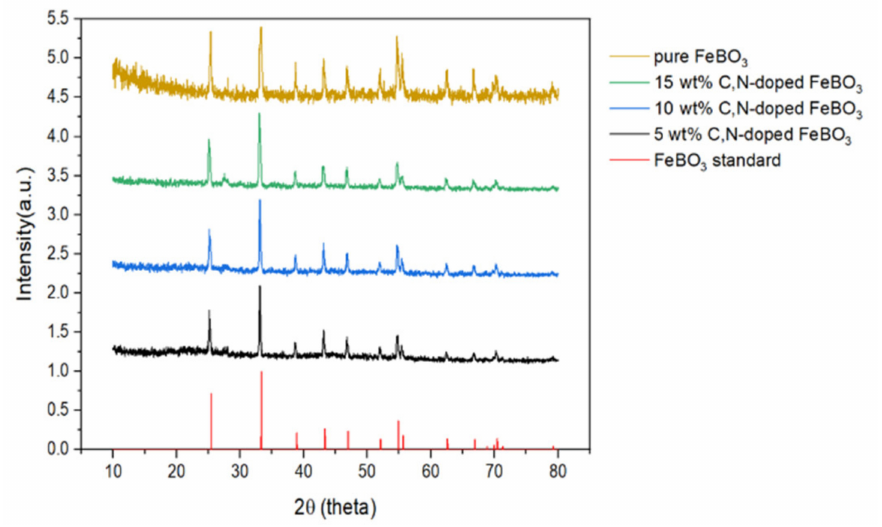
Figure 1. The XRD patterns of the various as-prepared C,N-doped FeBO 3 samples. The HR-TEM, STEM, and EDX mapping images of the C,N-doped FeBO 3 are